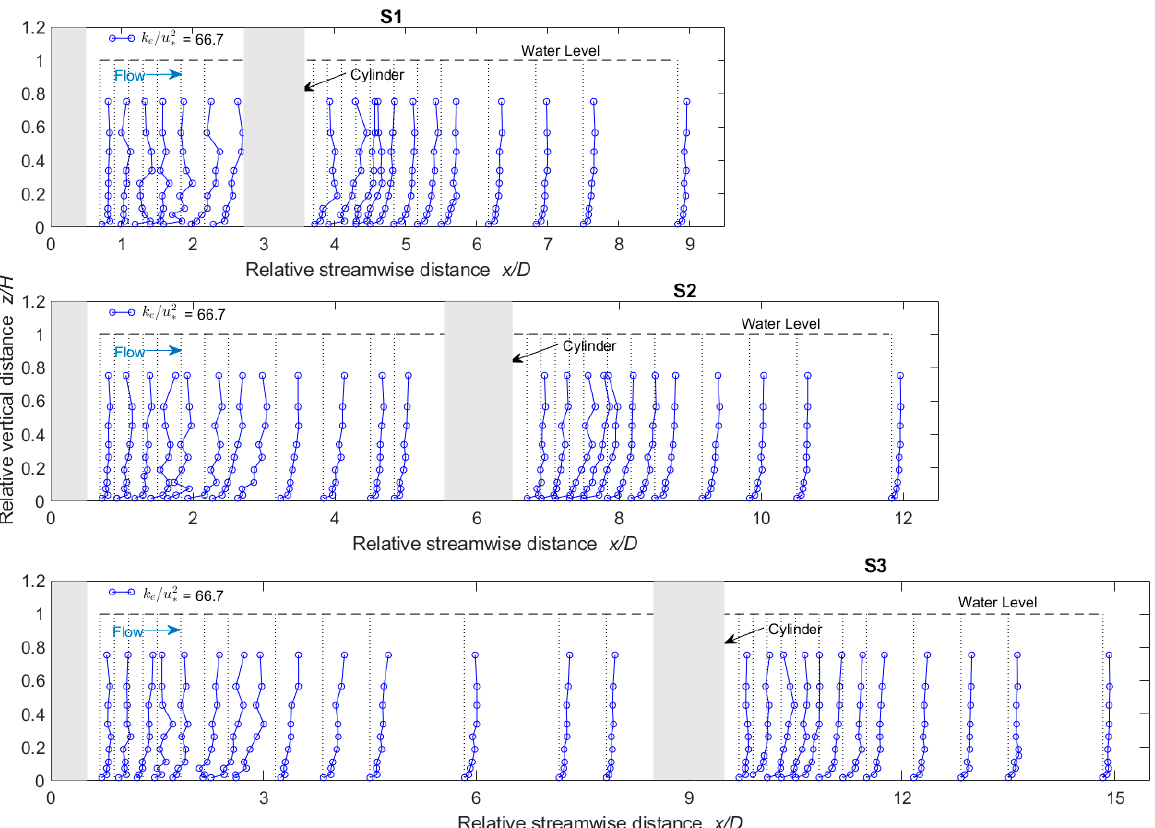
Figure 5. Vertical profiles of dimensionless turbulent kinetic energy ( k e /u * 2 ) in the symmetry plane for the 3 experimental scenarios S1, S2, and S3, combining both midstream and downstream.